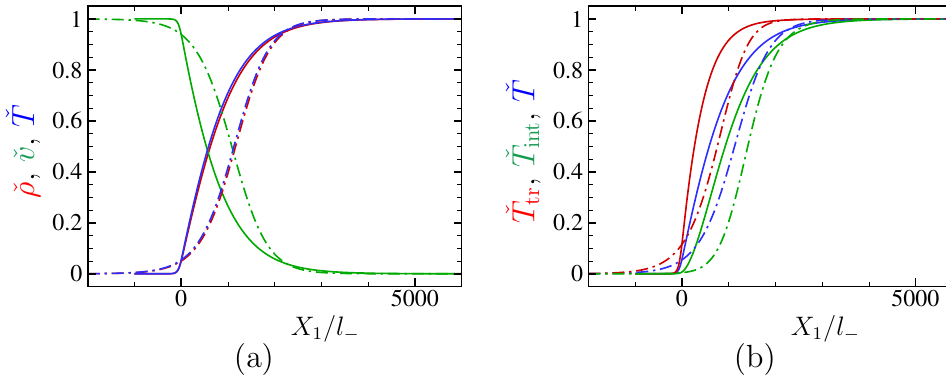
Figure 15. Profiles of ˇ ρ , ˇ v , ˇ T , ˇ T tr , and ˇ T int in the case of CH 4 gas at M − = 1.131 . . . . ( a ) ˇ ρ , ˇ v , and ˇ T ; ( b ) ˇ T tr , ˇ T int , and ˇ T . See the caption of Figure 2.